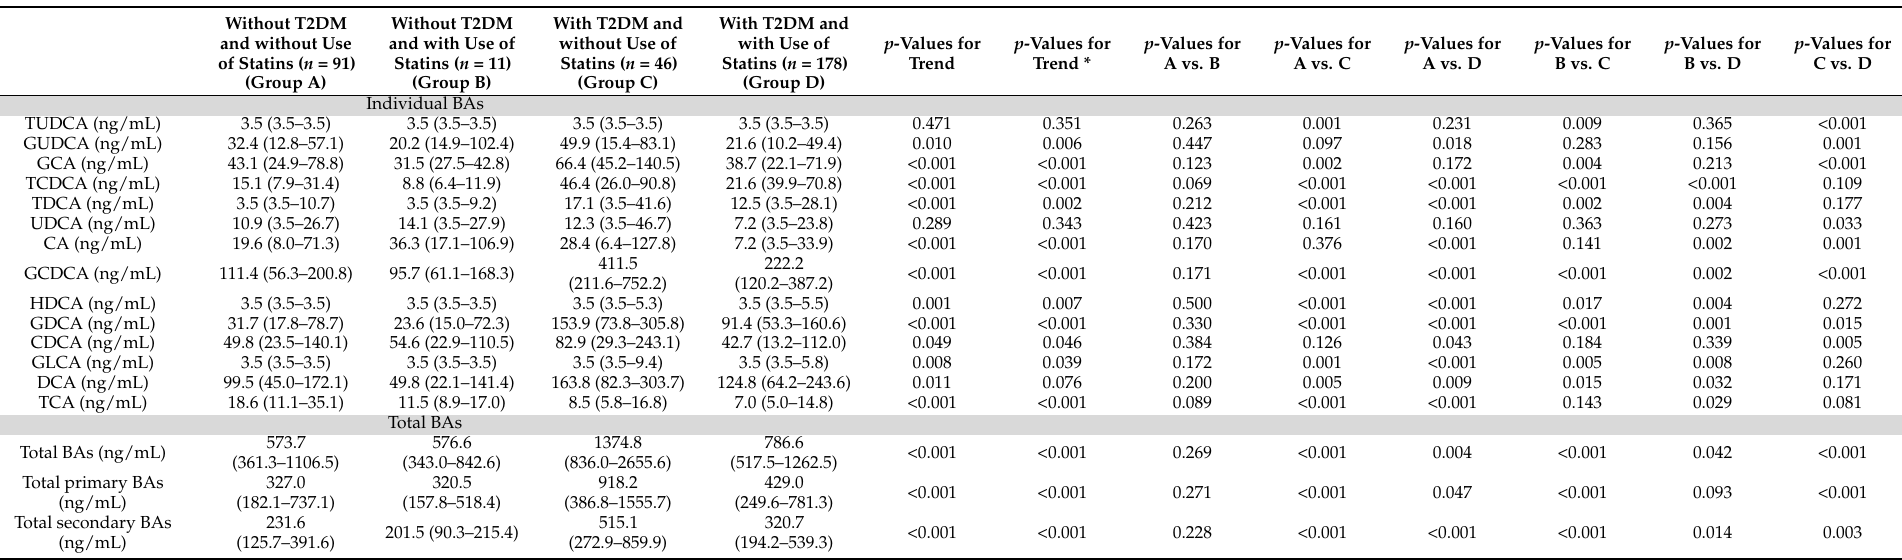
Table 3. Plasma BA concentrations in the whole population simultaneously stratified by T2DM status and statin